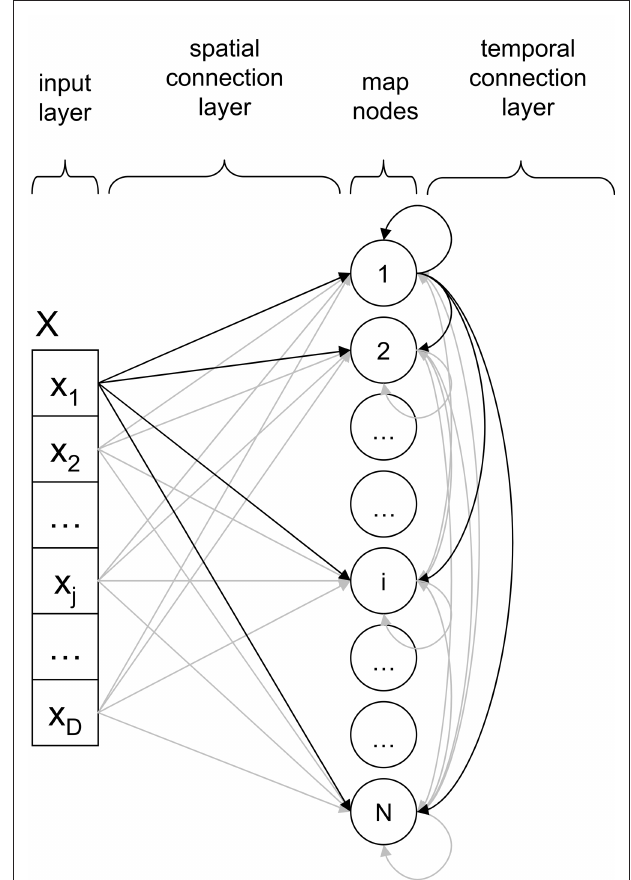
Figure 1 | Architecture of a THSOM